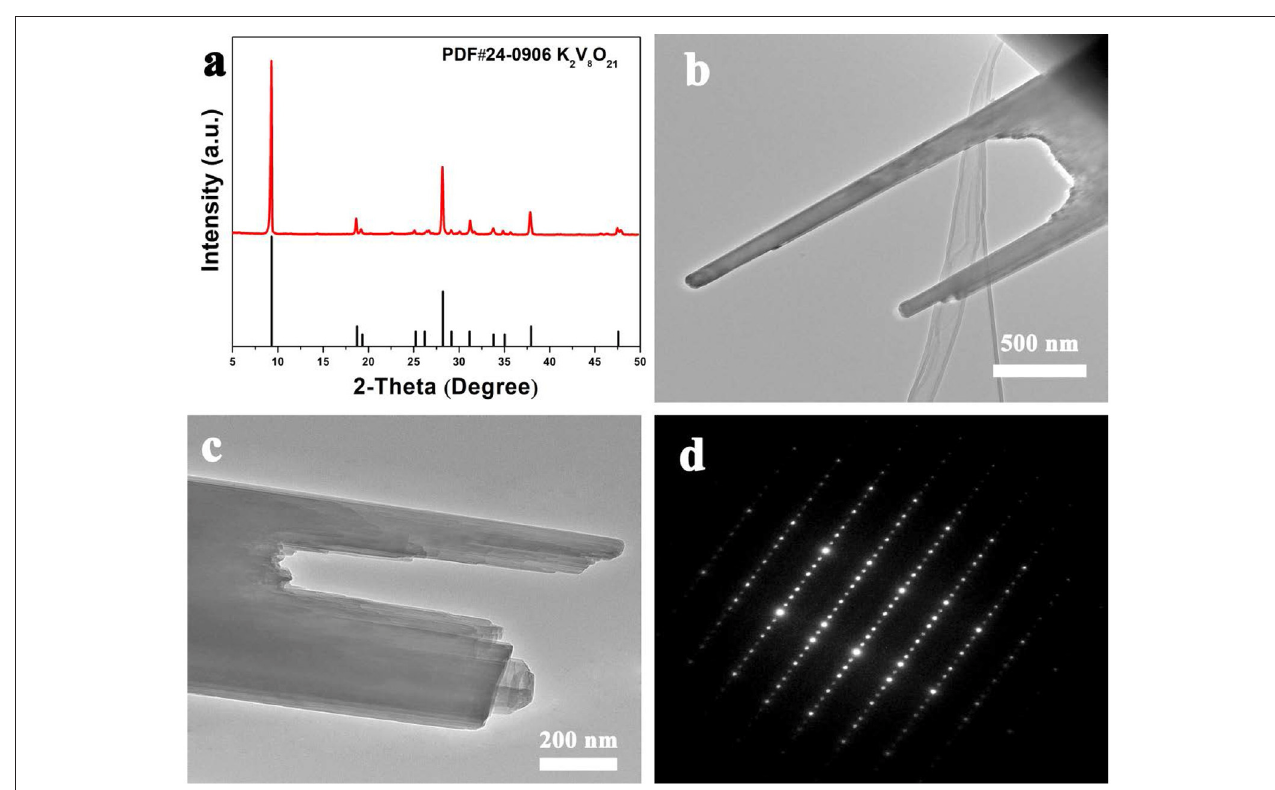
FIGURE 4 | (a) XRD patterns, (b,c) TEM images and (d) SAED patterns of the as-obtained K 2 V 8 O 21 .